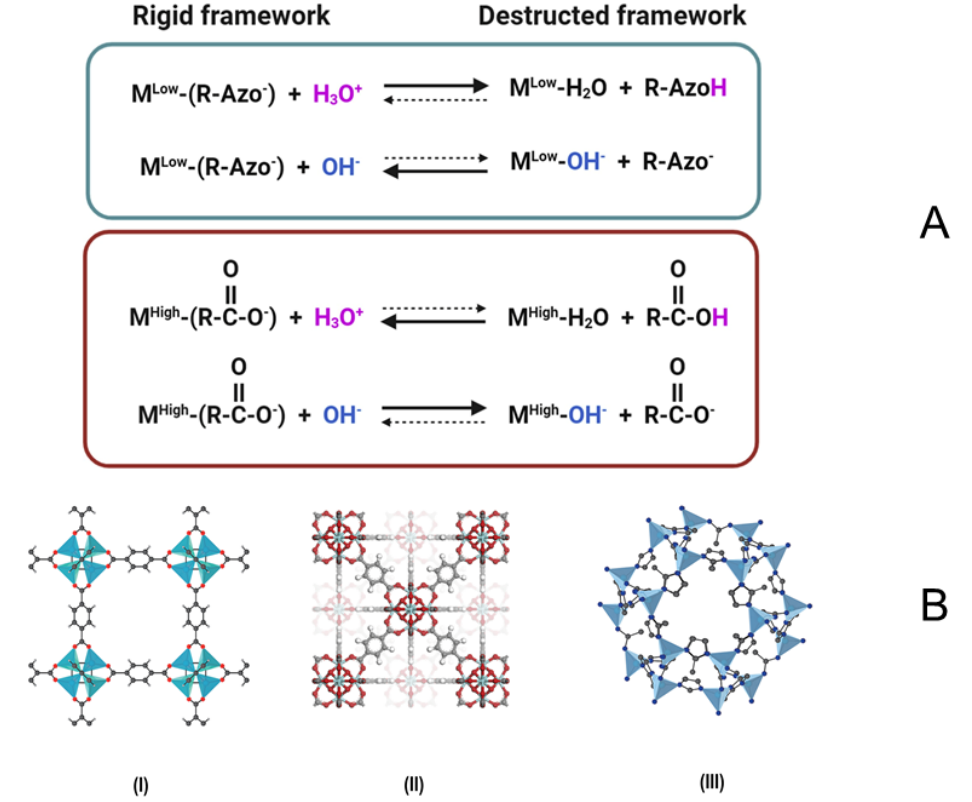
Figure 1. Metal–ligand substitution reactions between MOFs and protons/hydroxides M High /M Low , high-/low-valence metal nodes. Solid arrows represent a more favored process, and dashed arrows represent a less favored process. Adapted with permission from Ref. [13] 2021, Elsevier ( A ). The crystal structure diagrams for MOF-5 (I), UiO-66 (II), and ZIF-8 (III) [44] ( B ).